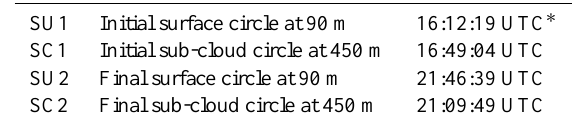
Table 1. Start times of CBL circles for RICO